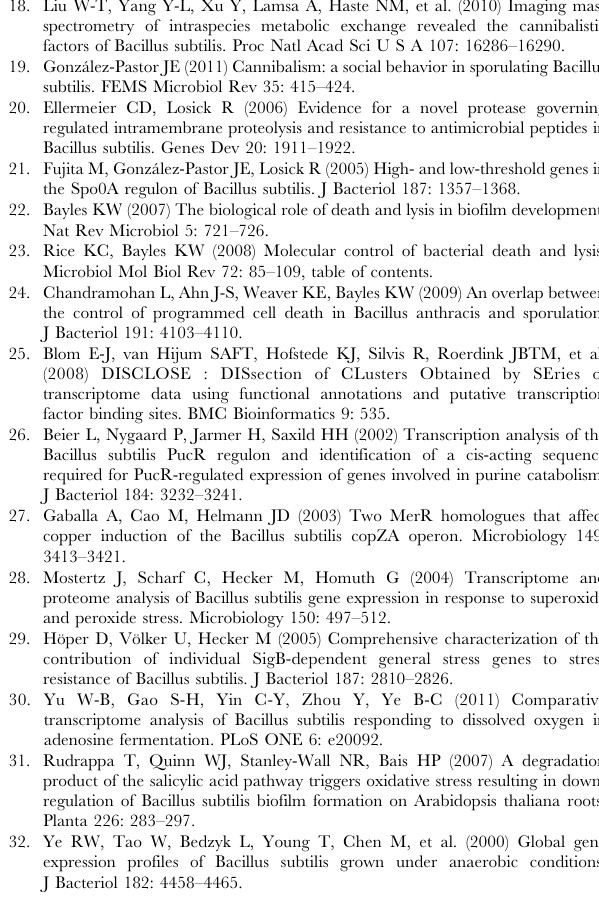
their upstream regions that was identified by DISCLOSE. The identified motifs are visualized as sequence logos in the third column. (TIF) Figure S6 Examples of genes showing correlation ( yktD ) or anti- correlation ( sdpC ) with oxygen. The different growth-phases that were identified by the PCA analysis are visualized in the expression graph. I: lag phase, II: exponential growth phase, III: early stationary growth phase. IV: late stationary growth phase. The asterisk represents the transition point.